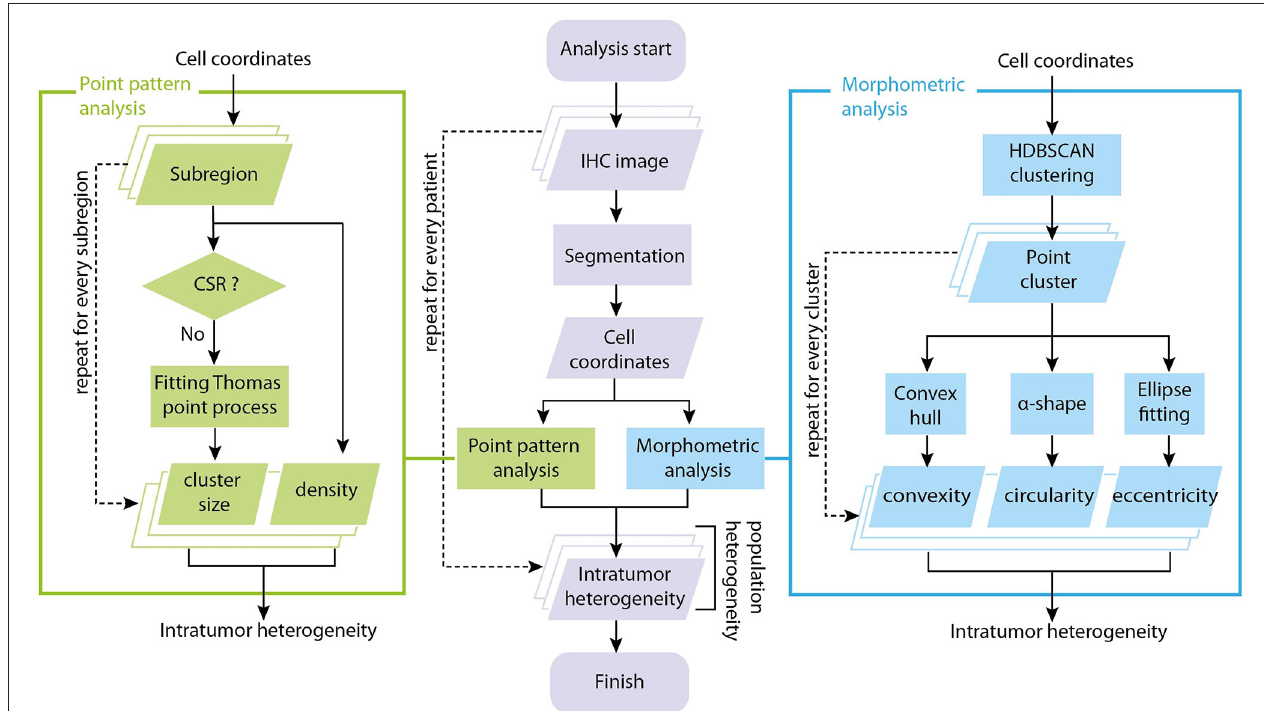
FIGURE 1 | Overall workflow of tumor spatial heterogeneity quantification. The analysis starts with brightfield IHC with CD8 staining. For each patient slide, we + perform image segmentation to obtain coordinates of CD8 T cells. The coordinate list from each slide is fed to two sub-procedures: spatial point pattern analysis + and morphometric analysis. In spatial point pattern analysis, local patterns are obtained using a moving window, tested for complete spatial randomness (CSR) and fitted to a clustering point process model if it is aggregated. In morphometric analysis, the full coordinate map is divided into clusters, and a series of shape descriptors are calculated for each cluster. The arrays of shape descriptors and fitted parameters constitutes a quantitative representation of the intra-tumoral (intra-slide) heterogeneity for that patient. We repeat the process on each slide to obtain measures of the inter-tumoral (inter-slide)